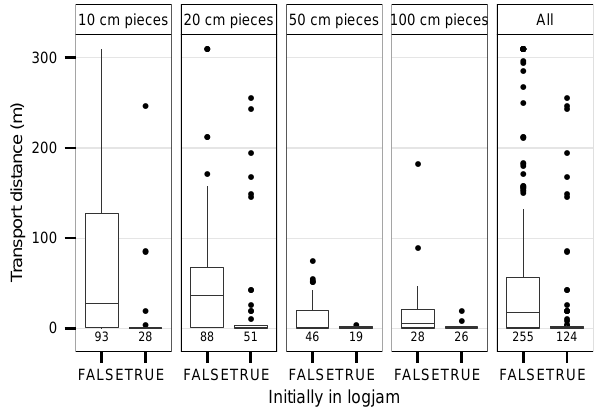
Figure 6. Transport distances of the tracer logs that were situated within or outside a log jam before the discharge event. The data are presented for four different length classes. The number below the plot gives the number of data points used in the analysis. The differences in median transport distances between pieces inside and outside log jams in the 10 and 20cm classes, as well as for all pieces combined, are highly significant.